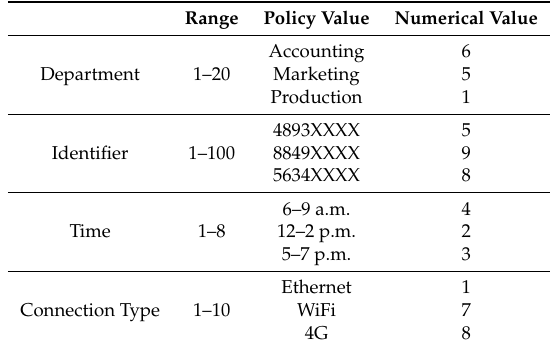
Table 6. Assignment of numerical values to policy